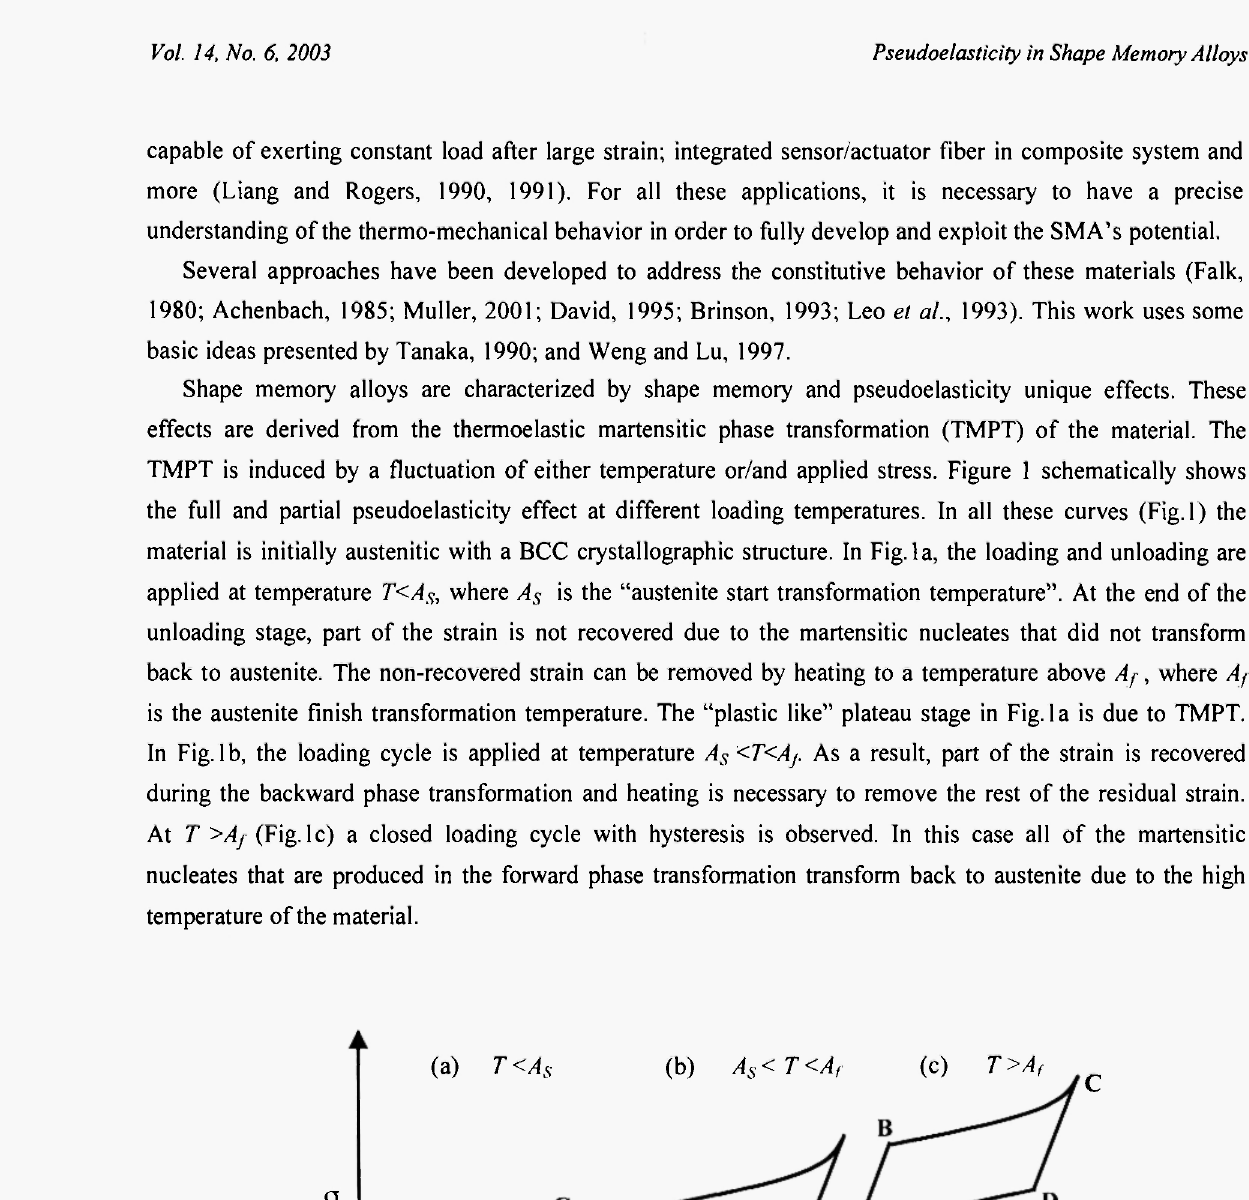
Fig. 1: Schematic stress-strain curves at different loading